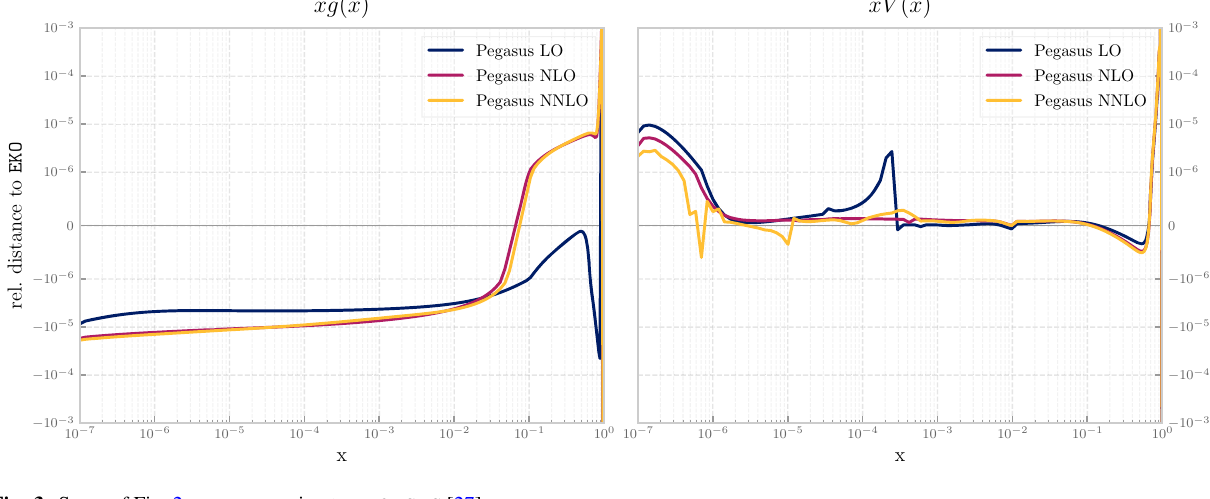
sectorweexpandEq.(6)firsttotheorderspecified,before solving the